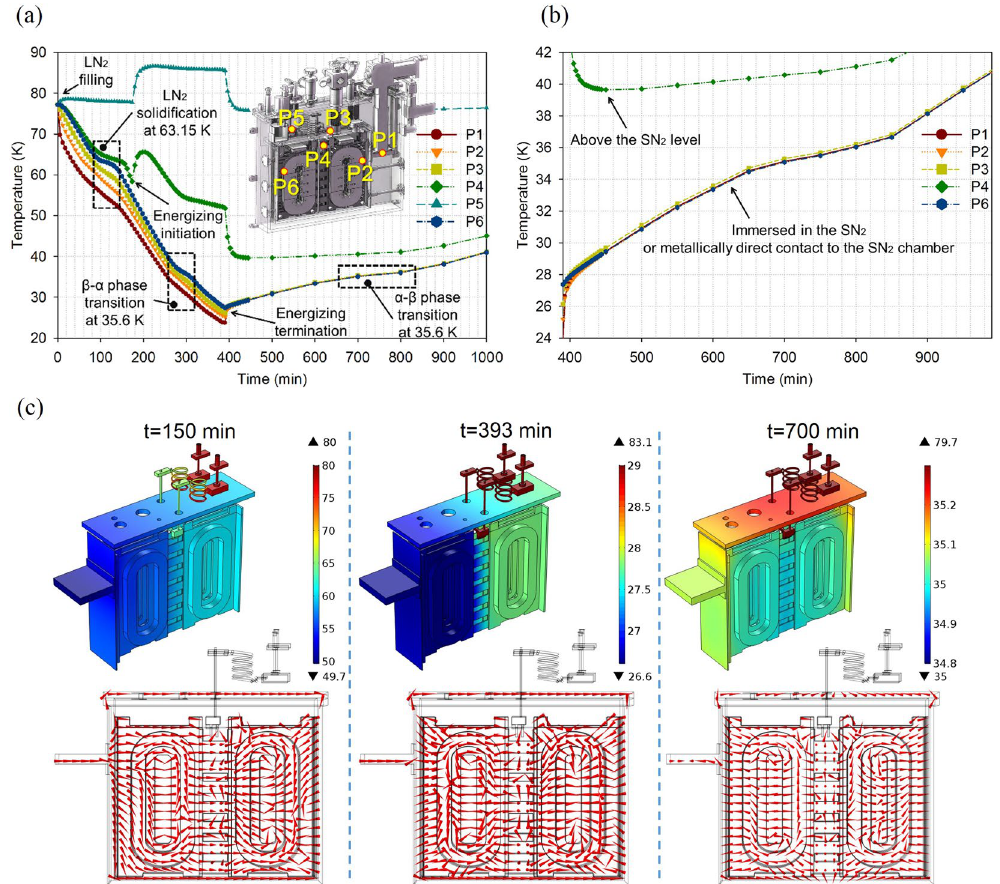
Figure 10. Temperature changes and cooling flux flows of the magnets system. Temperature curves at six typical locations ( a ) in the cooling-down process and ( b ) in the SN 2 cooling preservation process. Cooling flux flows and temperature distributions at ( c ) three time points corresponding to three different